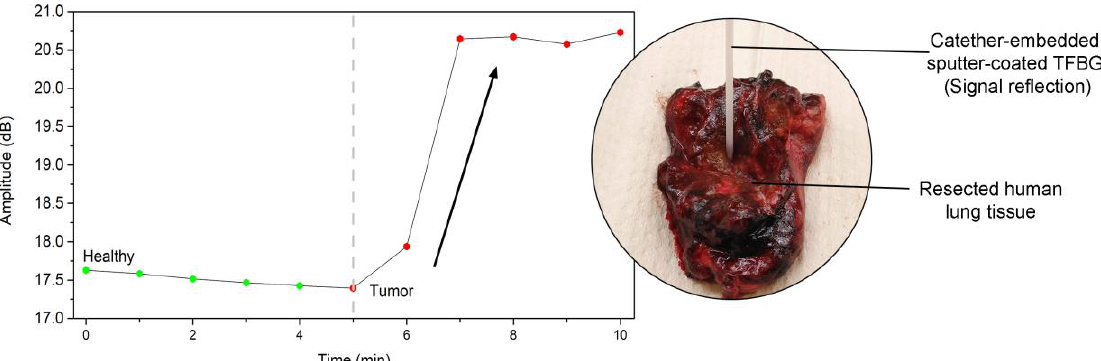
Figure 8. Graph showing the biosensor response in both healthy and tumorous parts of a resected human lung tissue. The biosensor was used at the tip of a catheter.